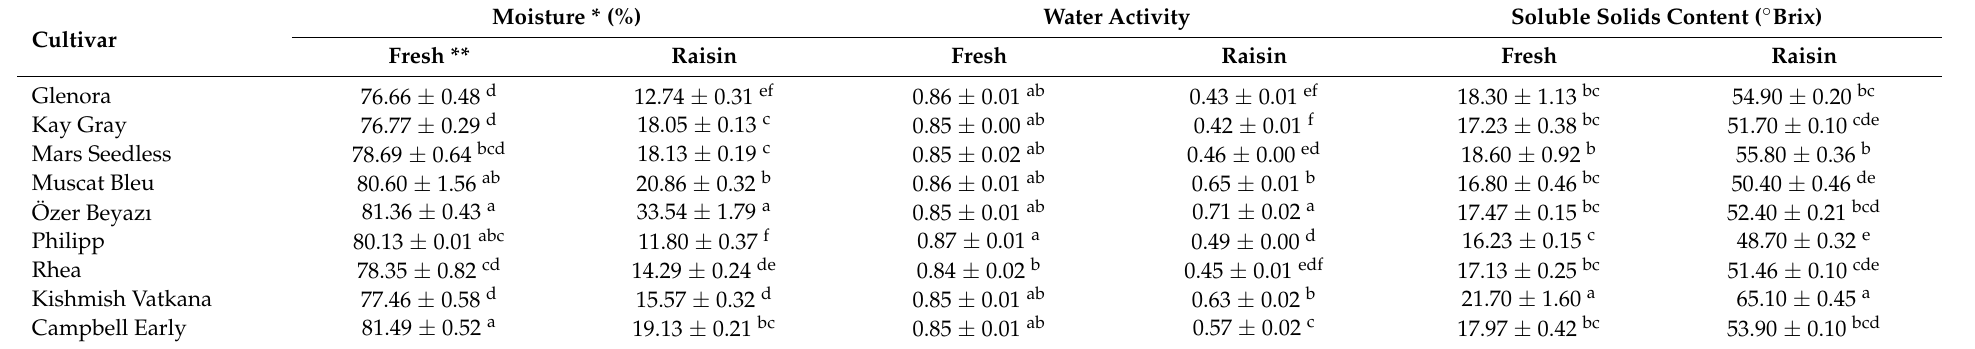
Table A3. Some of the physico-chemical properties of fresh grapes and their raisins from different cultivars.